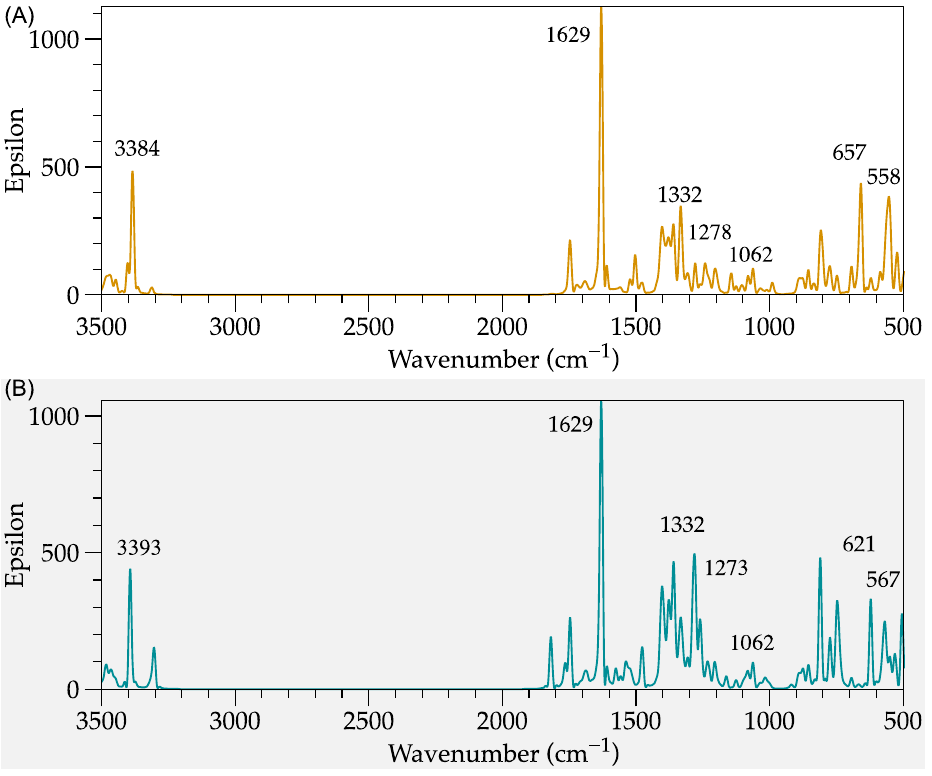
Figure 5. Theoretical infrared spectrum of ( A ) PAni-d SS and ( B ) PAni-d AMPS.